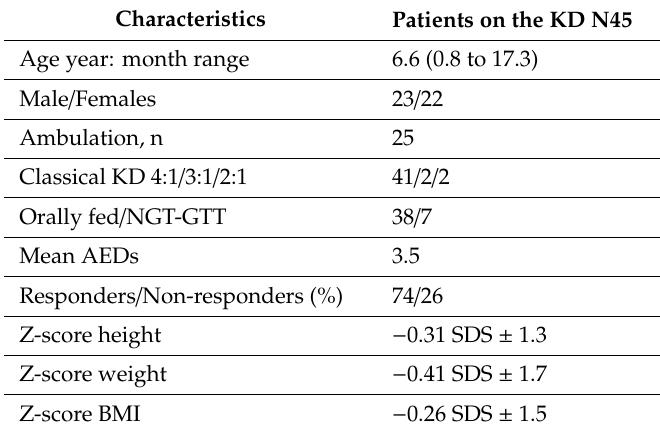
Table 1. Baseline characteristics of children with intractable epilepsy on the ketogenic diet (KD).